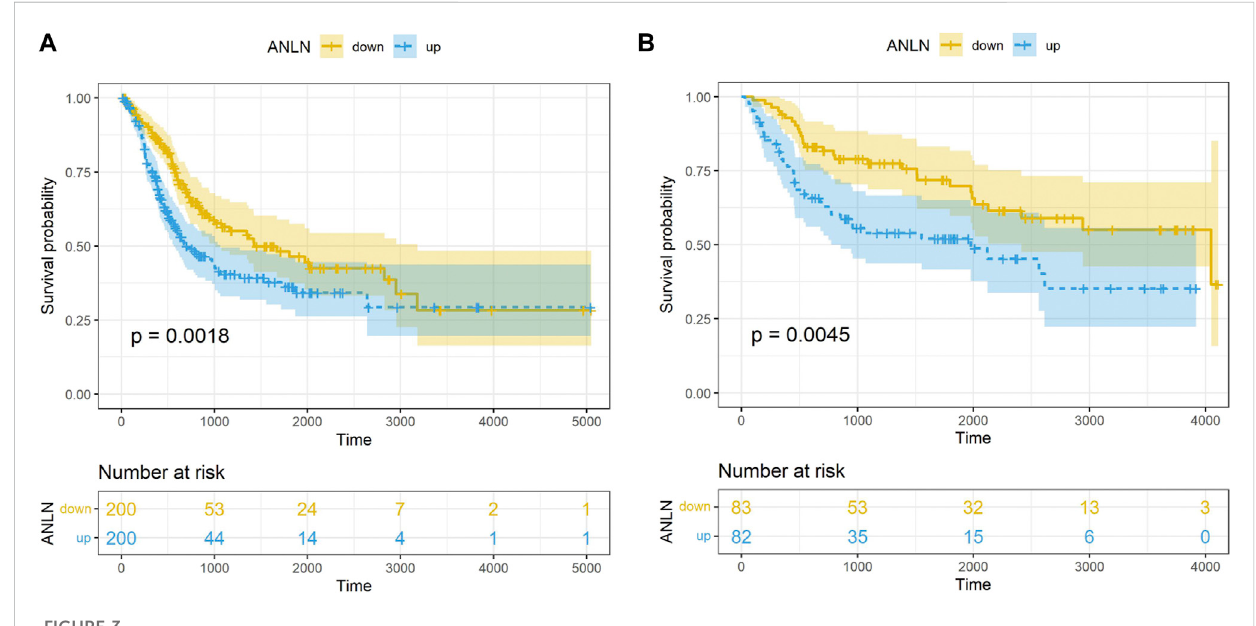
FIGURE 3 K-M survival analysis on the ANLN gene in dataset TCGA-BLCA (A) , GSE13507 (B)